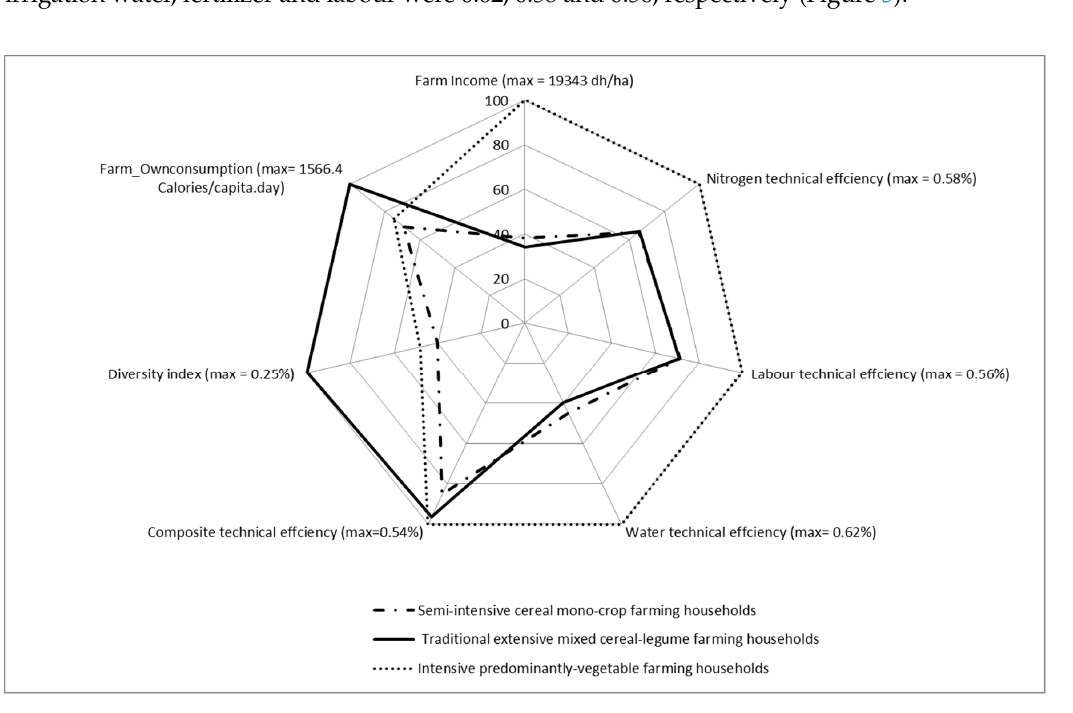
Figure 5. Average values of farm income, composite technical efficiency, farm self-consumption, diversity index, nitrogen technical efficiency, labour technical efficiency and water technical efficiency for the three farm types.